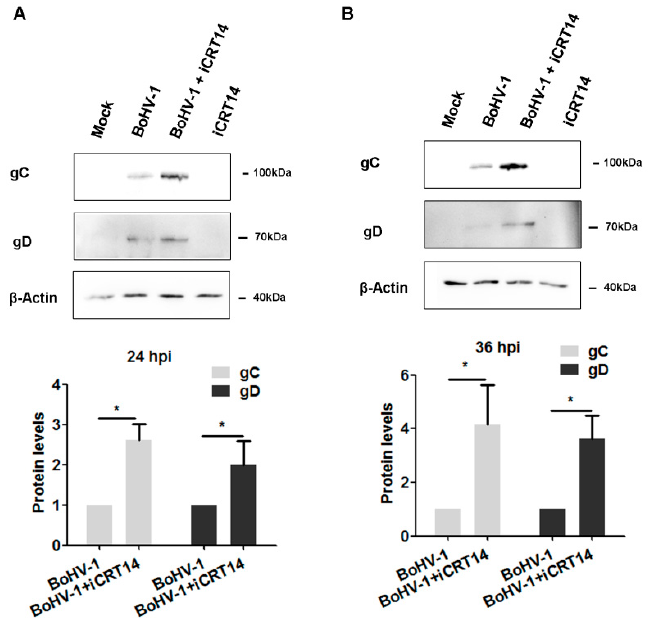
Figure 7. Effects of iCRT14 on BoHV-1 viral protein expression. A549 cells infected with BoHV-1 (MOI = 0.1) were mock-treated with vehicle DMSO or 10 µ M of iCRT14. After virus infection for 24 ( A ) and 36 h ( B ), along with treatment by the indicated chemicals, the cell lysates were prepared for Western blot analysis to detect viral proteins gC and gD. The band intensities of both gC and gD were initially normalized to β -Actin, and the fold change after virus infection was calculated by comparison to the uninfected control that was arbitrarily set as 1. Images shown represent the data of three independent experiments. Data shown in the right panel are the means ± SD of the three independent experiments. Statistical analyses were performed using Student’s t -test (* p < 0.05). 3. Discussion Exposure to various genotoxic stresses, such as UV treatment, leads to a sharp peak of γ H2AX and accumulation of γ H2AX at the sites of damaged DNA that forms high- lighted foci with IFA assay. γ H2AX foci or γ H2AX protein levels are widely detected to measure DNA damage [7]. Mechanically, the DNA damage due to BoHV-1 infection is largely different from that induced by exposure to canonical genotoxic reagents (such as UV exposure) because viral products, such as viral proteins and viral nucleic acid, are actively introduced into the nucleus. Unlike UV irradiation, the viral products cannot be retracted from virus-infected cells. By comparison with the data of comet assays, we found that the measurement of γ H2AX foci is acceptable to monitor virus infection-induced DNA damage. Interestingly, we found that a subset of γ H2AX foci was also located at the cytoplasm (Figure 2B). Though we could not explain the mechanism underlying the formation of γ H2AX foci in the cytoplasm, we speculate that the foci may be associated with mitochon- dria DNA damage because BoHV-1 infection also induces mitochondria dysfunction in bovine kidney (MDBK) cells [24], which deserves further study in the future. We found that virus infection led to the depletion of 53BP1 and reduced 53BP1 foci (Figure 3), which may impair 53BP1-mediated DNA damage repair and, consequently, account for virus-induced DNA damage. The depletion of 53BP1 was likely a result of the virus-mediated host shutoff activity because viral proteins, such as bICP27, are able to inhibit host gene expression [25], and bICP0 could promote proteasome-dependent deg- radation of certain cellular proteins [26]. Given that 53BP1 plays a critical role in DNA damage repair, further study revealing the detailed mechanisms of 53BP1 depletion is an interesting subject that remains to be determined in the future.